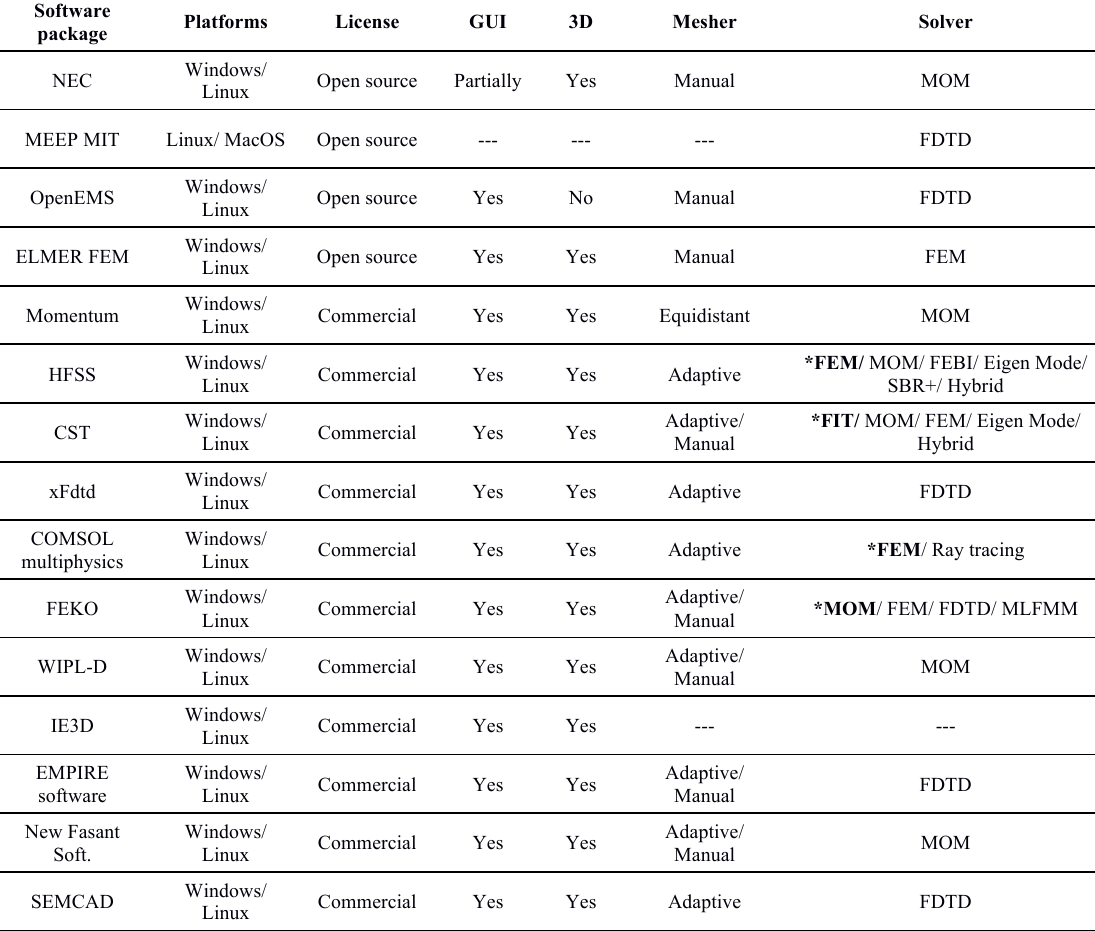
Table IV. Benchmark of existing open-source and commercial CEM Software Software